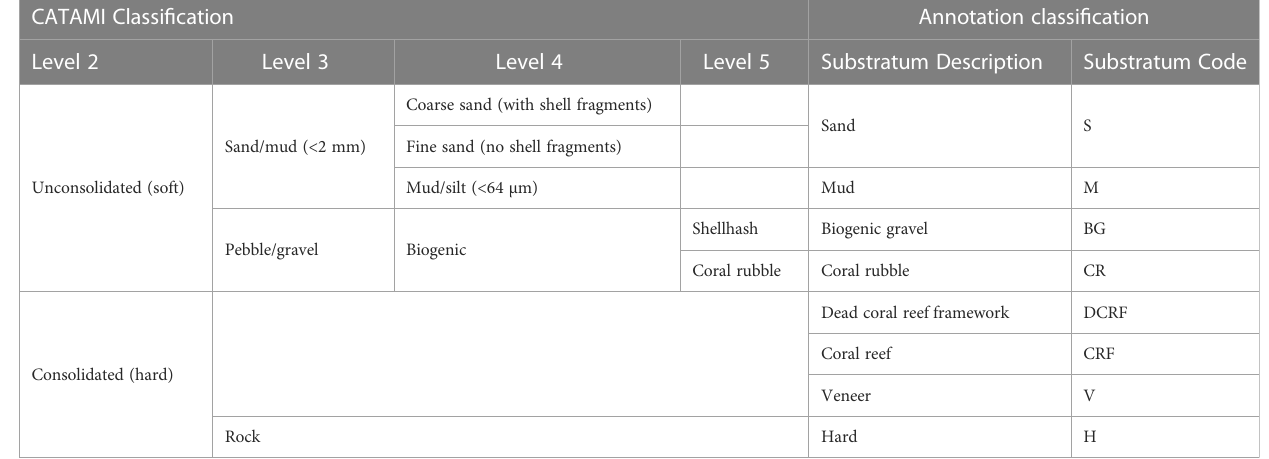
TABLE 3 Substratum classi fi cation used in annotation of image data.